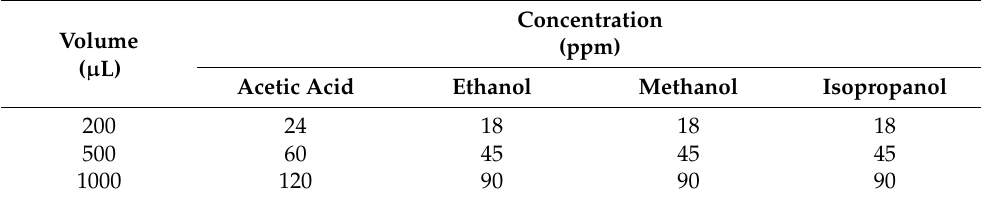
Table 1. Evaporated volumes ( μ L) and respective concentration levels (ppm) for the four considered VOCs; acetic acid, ethanol, methanol, and isopropanol. Volume ( μ L)